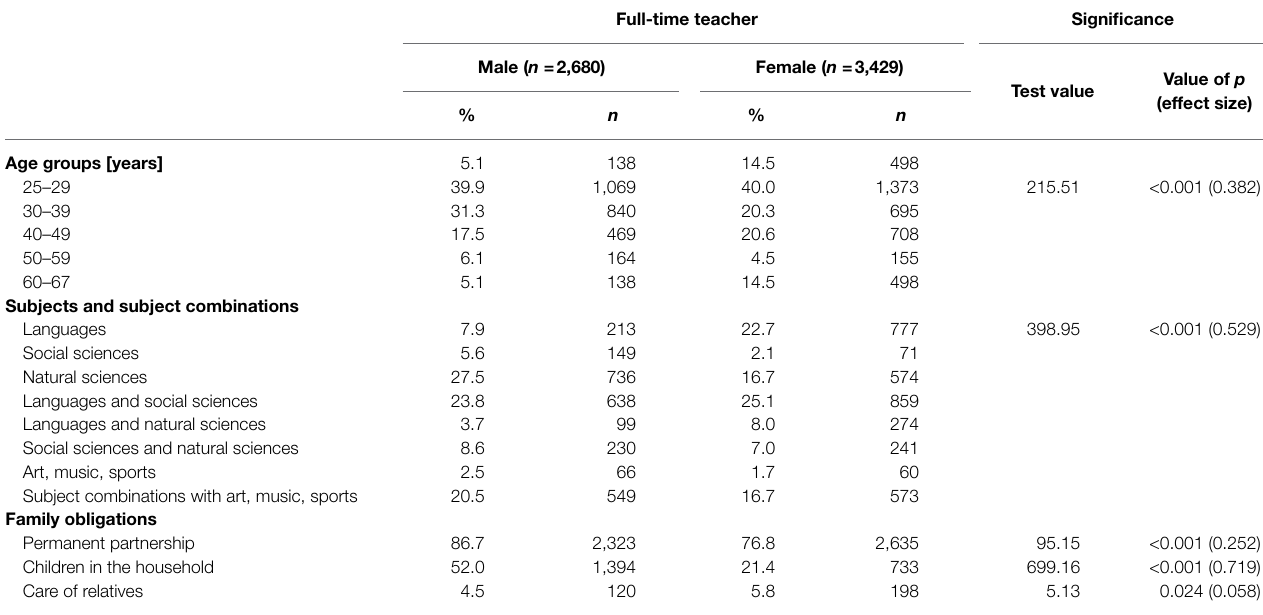
TABLE 1 | Characteristics of the sample of male and female full-time